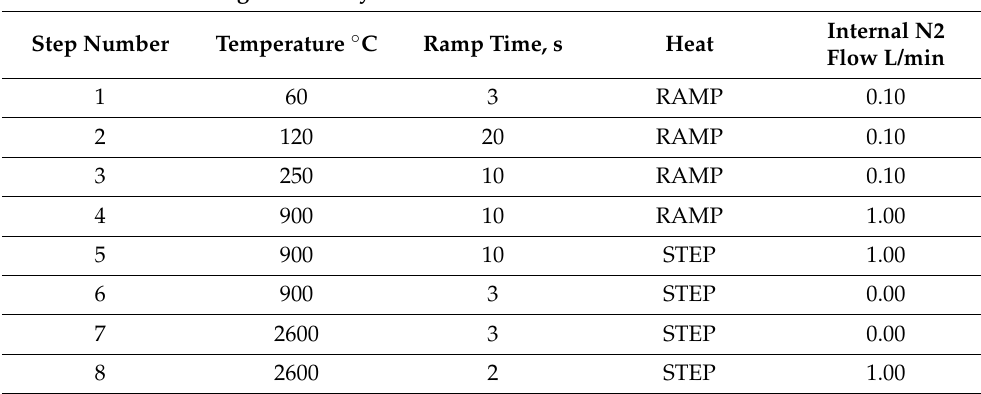
Table 1. FAAS operating parameters for the determination of Al, Shimadzu cookbook. Instrument Settings and Analytical Conditions of FAAS for the Determination of Al